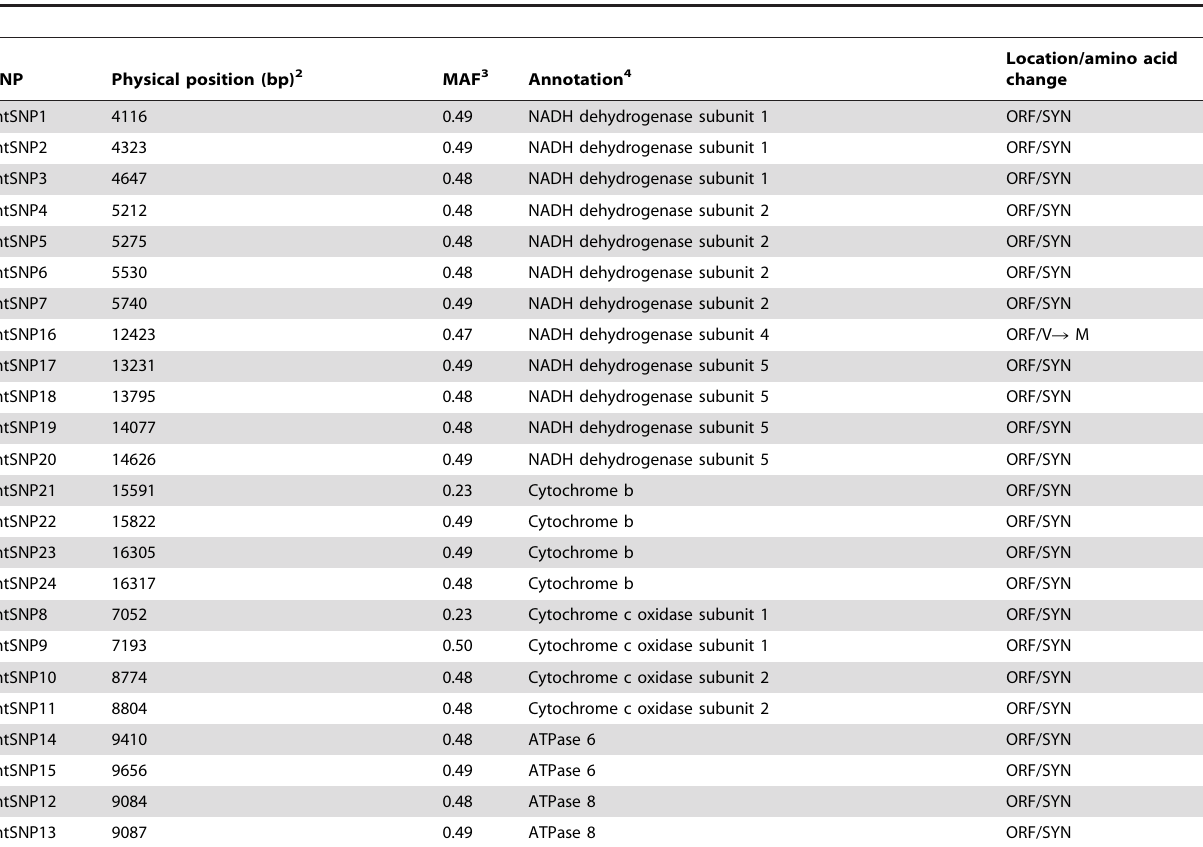
Table 6. Summary of mitochondrial markers significantly associated 1 with growth traits and their annotations 1